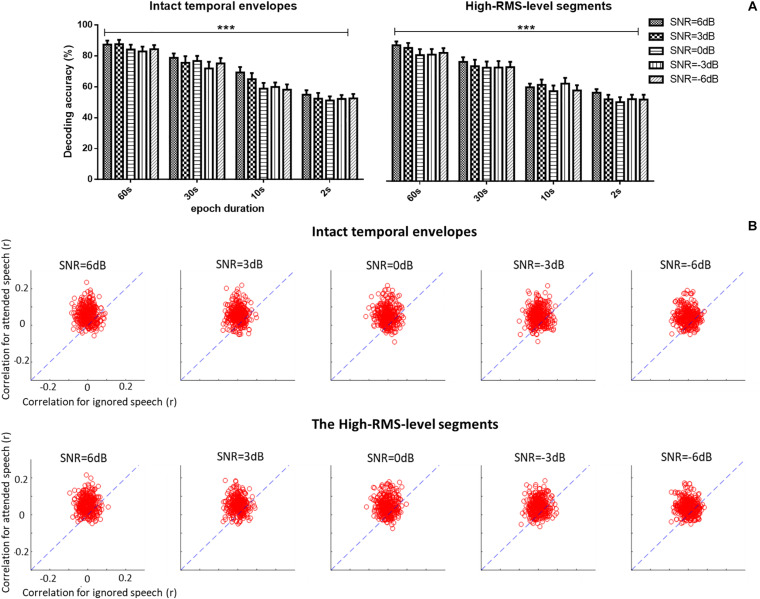
(A) Average auditory attention-decoding accuracy across subjects with the intact temporal envelopes and high-RMS-level segments for each signal-to-noise ratio (SNR) with the duration of decoding window at 60, 30, 10, and 2 s. Error bars display mean ± standard deviation. ***P < 0.001. n.s., no significant difference (analysis of variance). (B) Scatter plots of the correlation of attended vs. ignored streams across all trials and subjects for each signal-to-noise ratio (SNR) with 60 s decoding window length. Points above the blue dashed lines indicate the correct identification of attended speech.